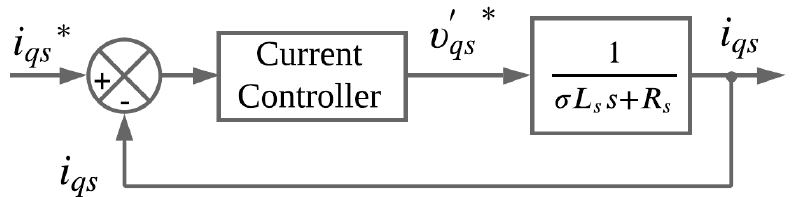
Figure 16. Current control loop diagram.